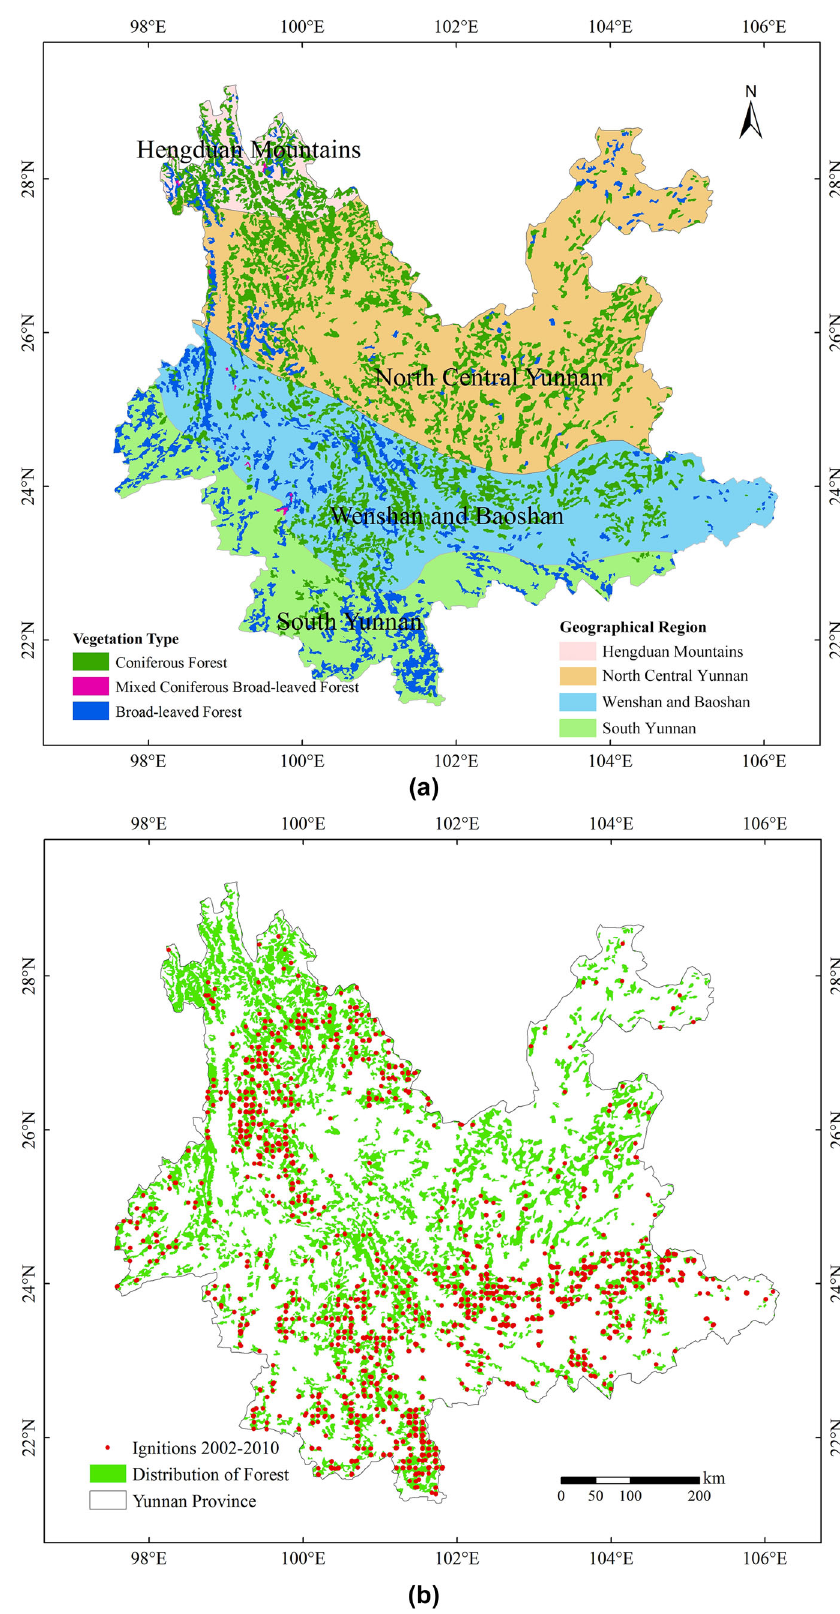
Fig. 1 Distribution of forest in Yunnan Province, overlaid with the physico-geographical characteristics of the regions ( a ) and the wildfire ignition distribution, 2002–2010 ( b ). Data source a Huang (1989) and Zhang (2007); b http://